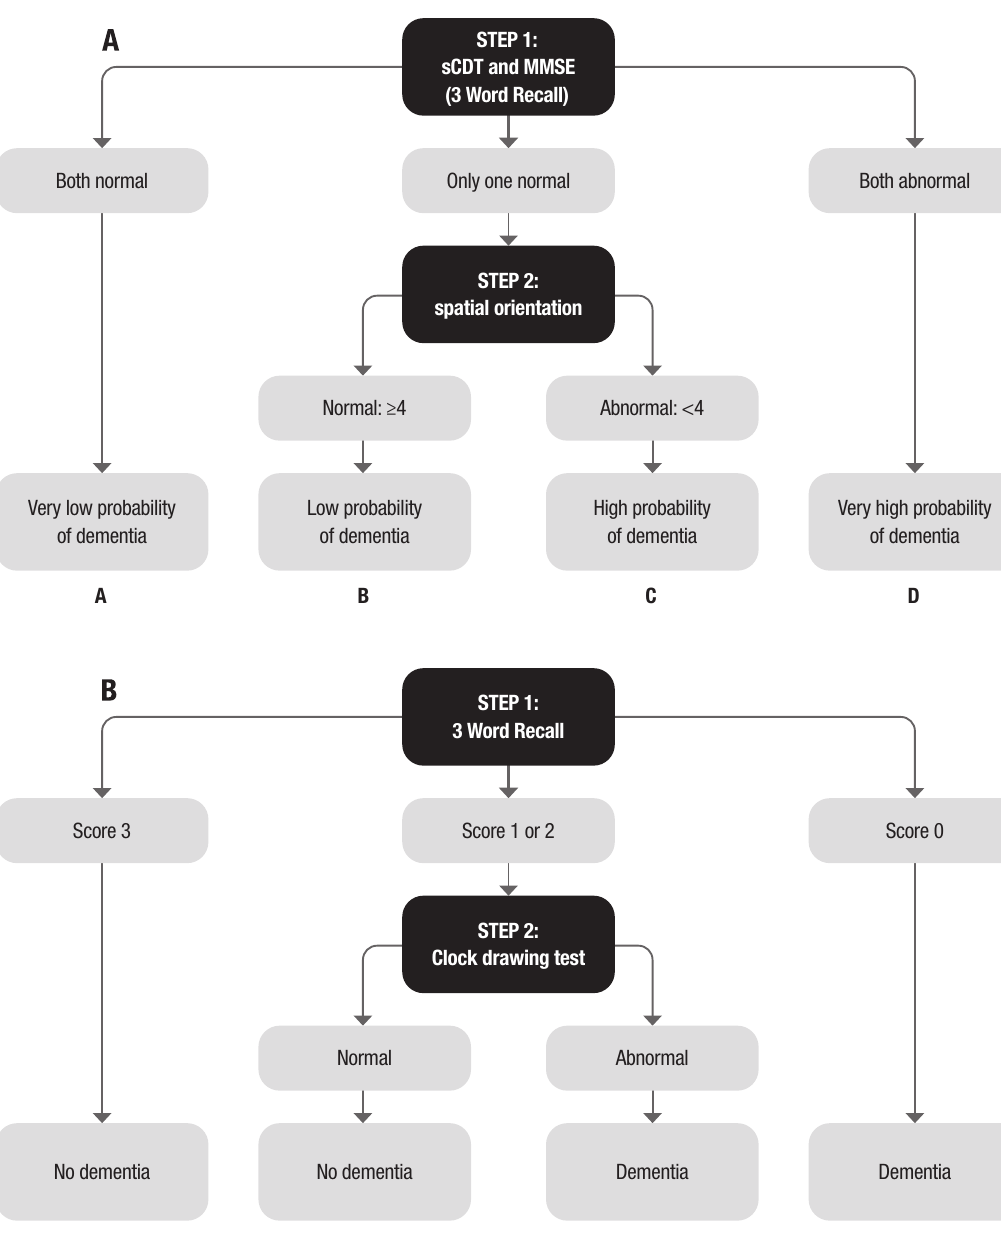
Figure 1 . [A] Codex decision tree. [B] Mini-Cog rewritten as a decision tree using scoring method of Borson et al.